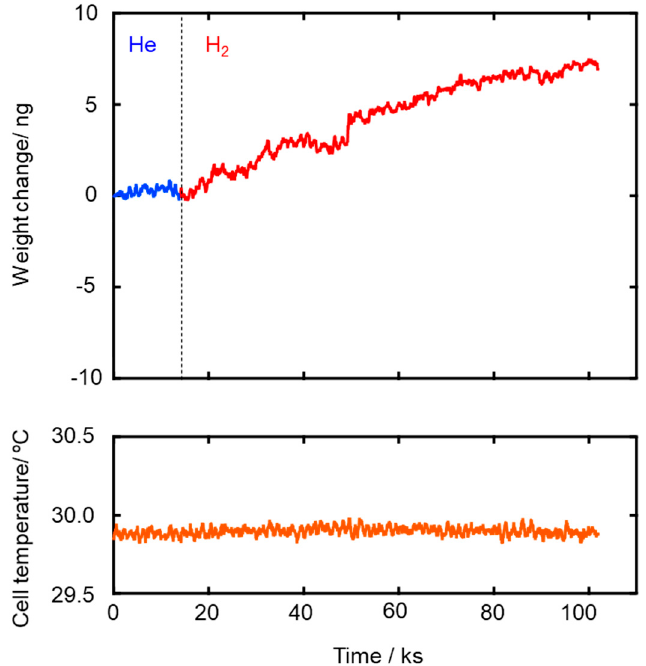
Figure 6. Weightgainmeasuredat30 ◦ CforH 2 Figure 6. Weight gain measured at 30 °C for H 2 adsorption to the sample film of the SiCH organic– inorganic hybrid prepared by 300 °C-heat treatment in Ar.